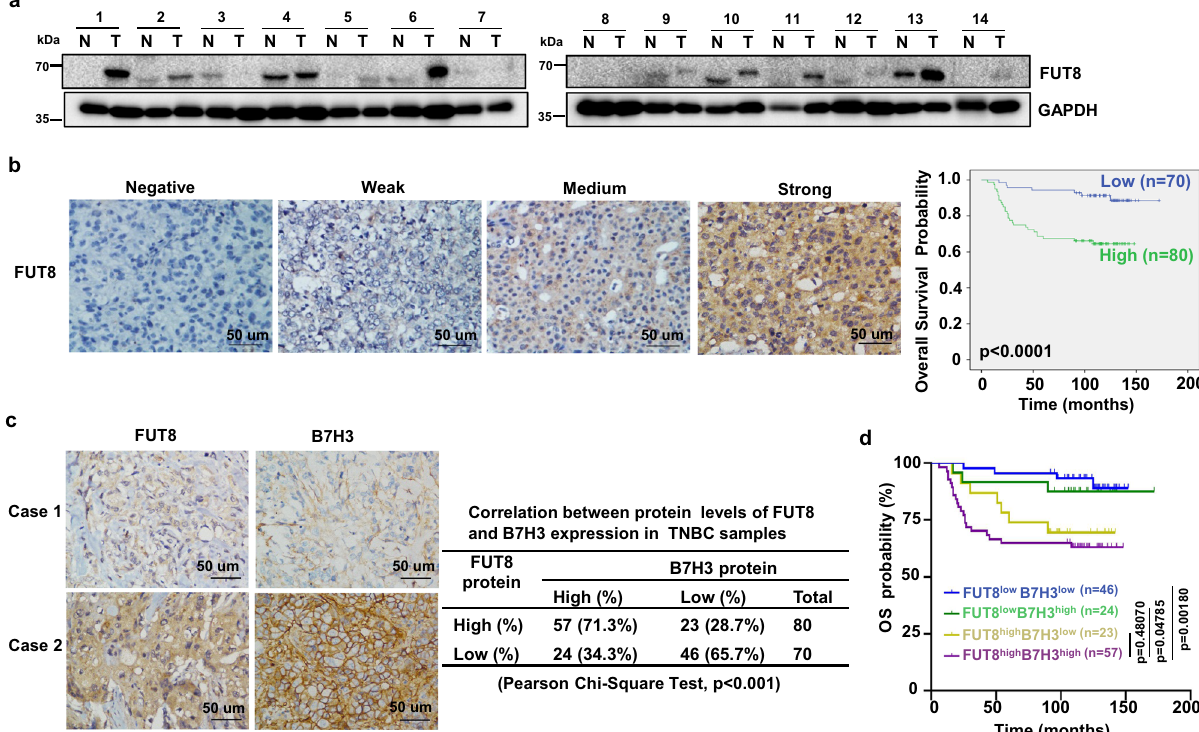
Fig. 7 Correlations among FUT8 and B7H3 expression in TNBC tissues. a Expression of FUT8 protein in 14 representative human TNBC fresh samples by immunoblot. N, matched normal tissue; T, tumor tissue. b The representative intensity images for each IHC score of FUT8 staining in TNBC tumor tissues were shown (left). Kaplan – Meier plots of the overall survival of patients, strati fi ed by protein expression of FUT8 (right). The p value was assessed using the log-rank test (two-sided). c The representative images for B7H3 staining in two patients with FUT8 expression (left). Case 1 showed low expression of FUT8 with low expression of B7H3. Case 2 showed high expression of FUT8 with high expression of B7H3. The correlation of B7H3 with FUT8 expression status in TNBC patient tumors (right). The relationship was assessed using Pearson ’ s chi-square test. d Kaplan – Meier plots of the overall survival of patients, strati fi ed by protein expression of both B7H3 and FUT8. The p value was assessed using the log-rank test and further corrected with the Benjamini – Hochberg method Plasmids . Human full-length B7H3 and mouse B7H3 cDNA (with fused C- terminal Flag tag) were subcloned into pCDH-CMV-MCS-EF1 vector (System Biosciences) to establish stably transfected cells. In addition, human full-length B7H3-Flag also cloned into pcDNA3.1 vector (Invitrogen) for transient transfec-